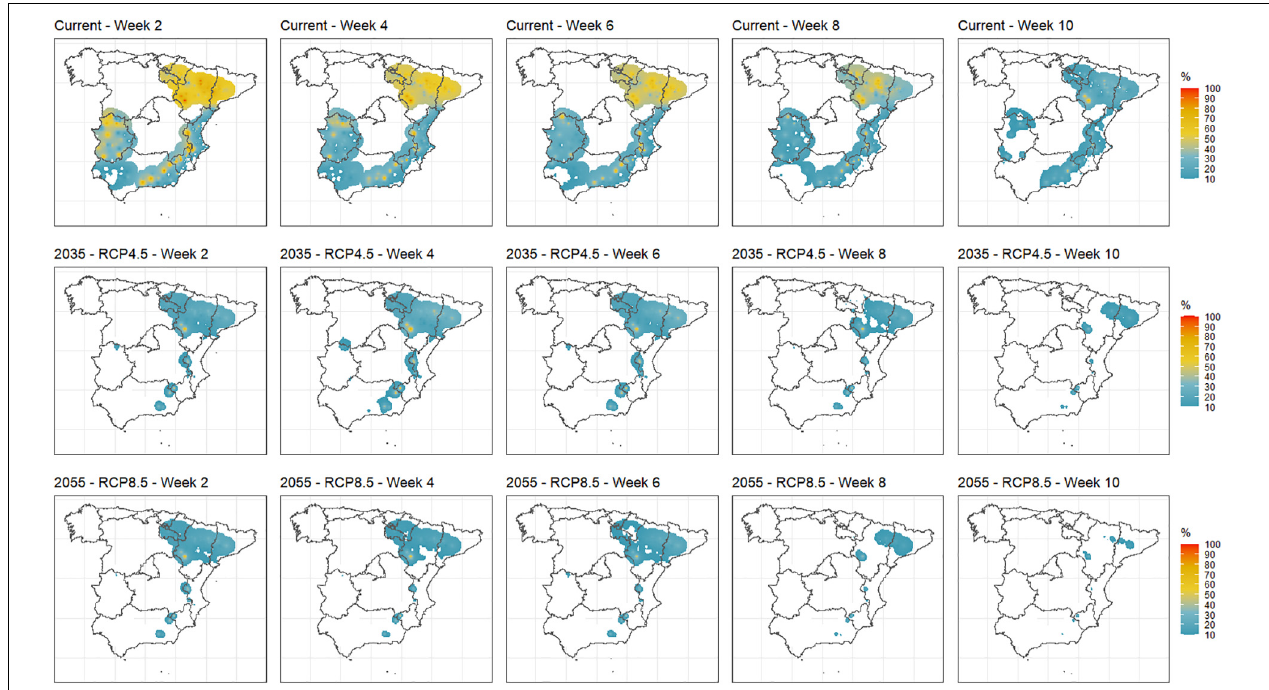
FIGURE 5 | Probability of frost events in the main stone production areas in Spain for weeks 2 to 10 for the current, 2035_RCP4.5 and 2055_RCP8.5 scenarios.